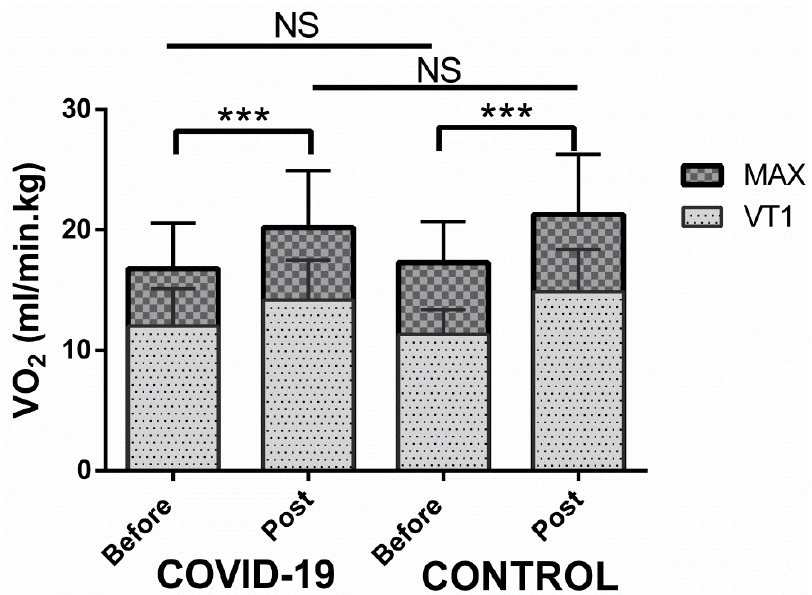
Figure 1. VO 2 peak gain after cardiopulmonary rehabilitation in COVID-19 patients and in cardiac patients. The VO 2 at ventilatory threshold 1 (VT1) and at the end of the exercise (MAX) were improved after 25 cardio-pulmonary rehabilitation sessions in COVID-19 patients and control group (cardiac patients). No statistical difference was found between these two groups. NS = non-significant; *** p < 0.001.